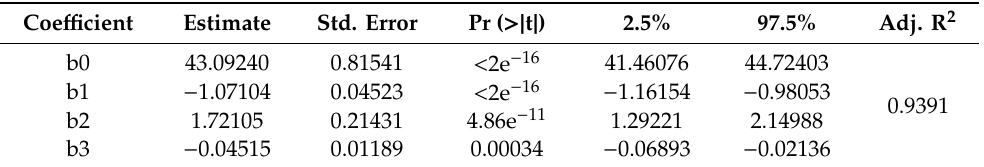
Table 10. Results of the regression analysis and coe ffi cient estimation—modulus of elasticity (E = 39.7295